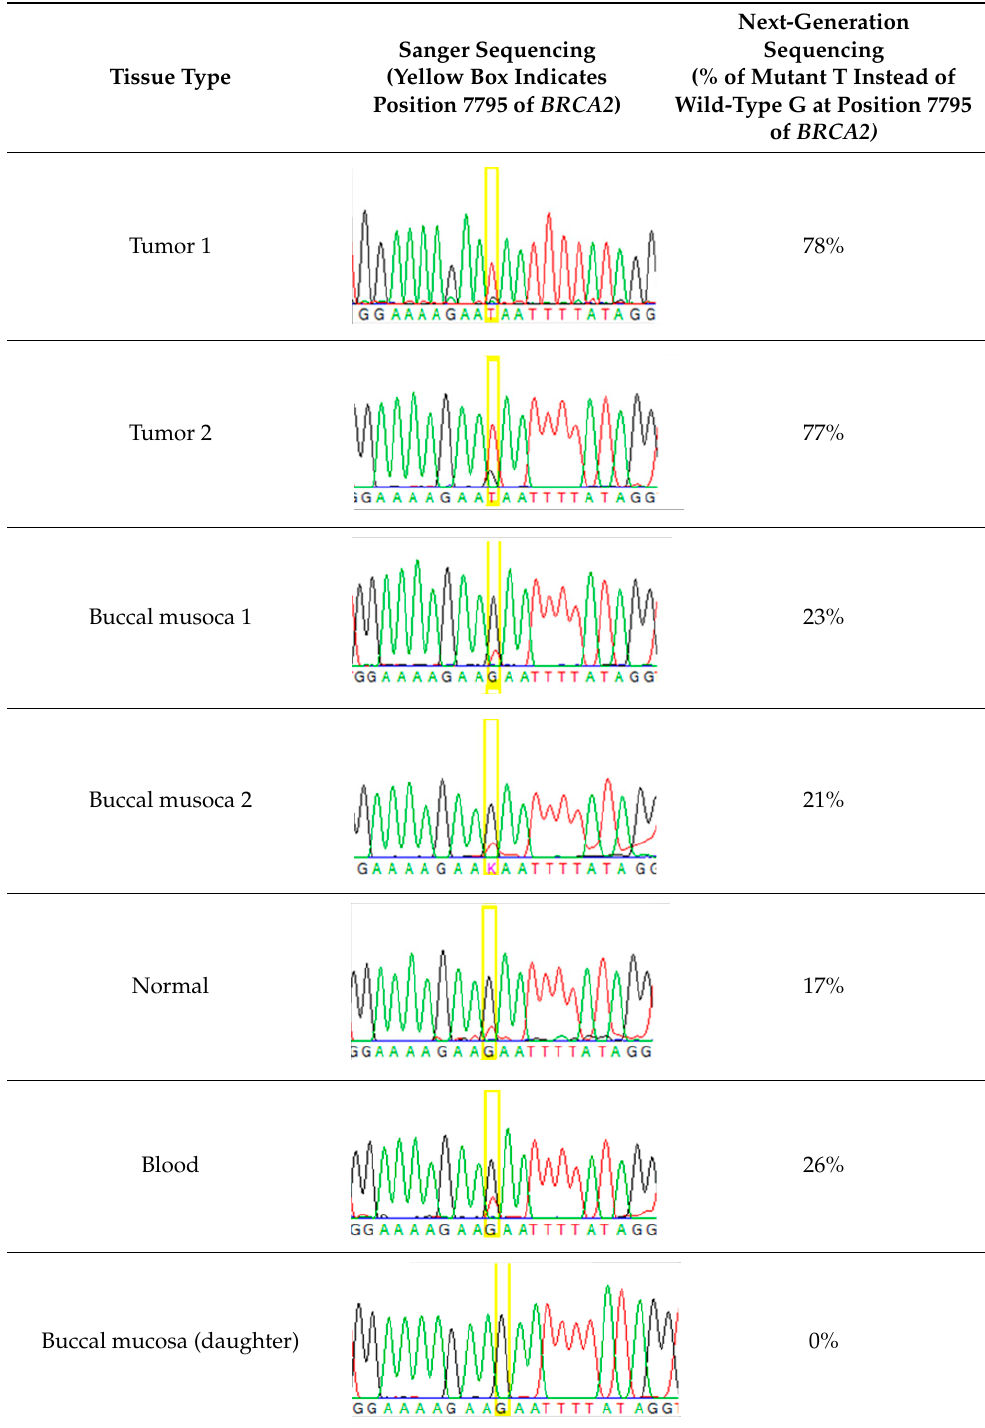
Table 1. Summary of the results of the Sanger and next-generation sequencing on different tissues from the patient (tumor, buccal mucosa, blood, and tumor-free “normal” ovary tissue surrounding the tumor) and her daughter (buccal mucosa).